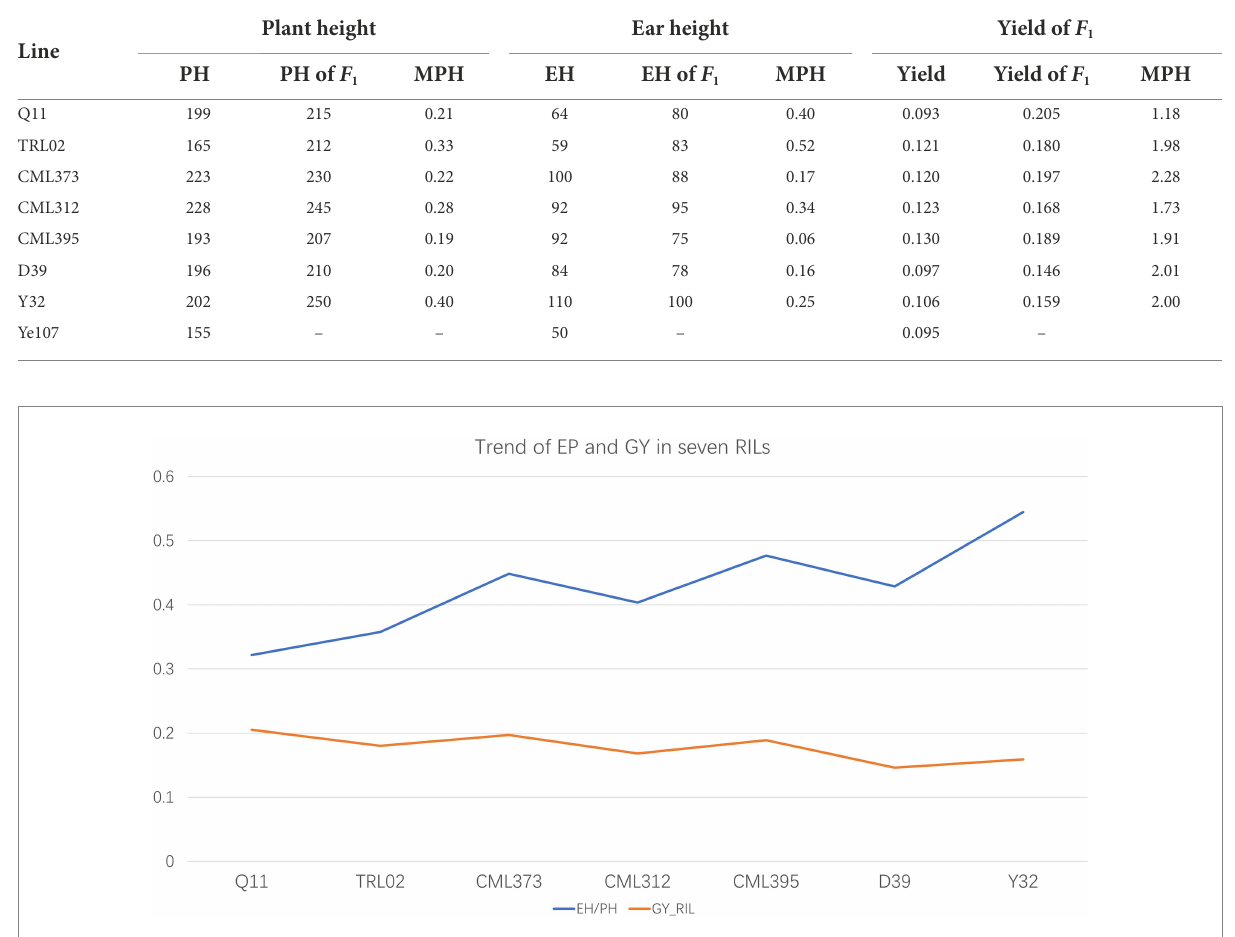
FIGURE 3 The trends of grain yield and ratio of ear height and plant height are in opposite direction in the seven recombinant inbred line populations at current plant